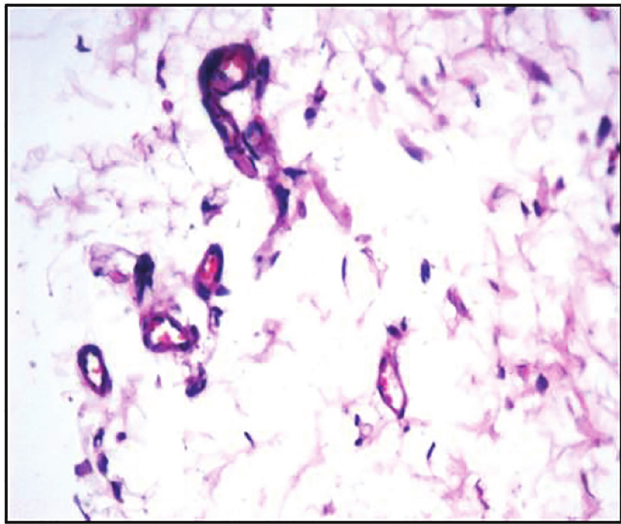
FIGURE 2 (J) - Photomicrograph of section of skin of neonate of pregnant rat exposed to pesticide carbendazim shows normal sized vessels with no congested blood vessels) (H & E